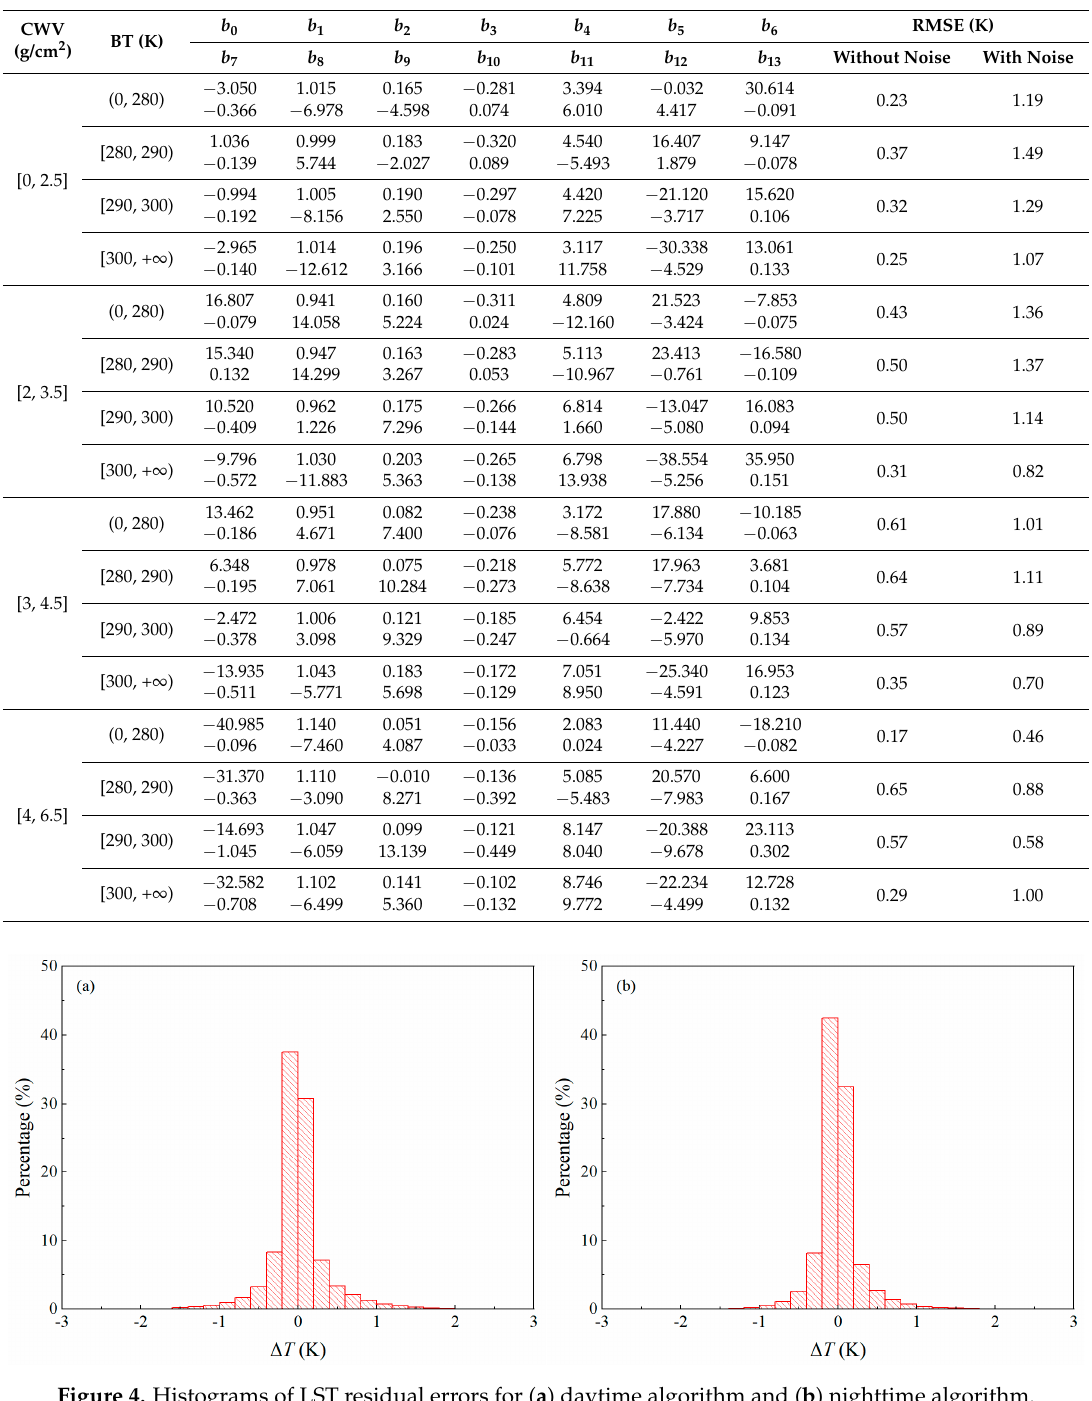
Figure 4. Histograms of LST residual errors for ( a ) daytime algorithm and ( b ) nighttime algorithm.